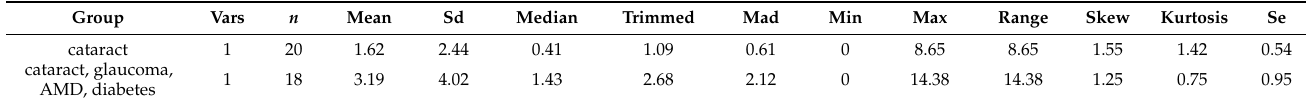
Table 8. Descriptive statistics for cataract group and cataract with coexisting ocular pathologies (glaucoma, AMD) and diabetes.